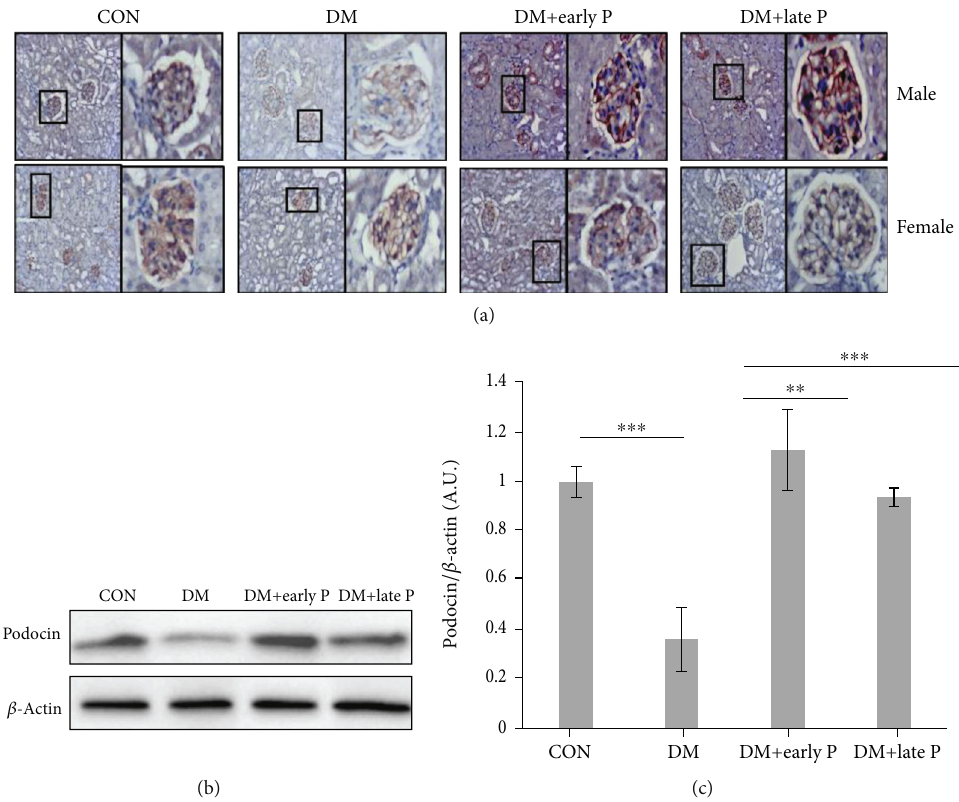
Figure 6: Immunohistochemical analysis of podocin expression in mouse renal tissues. (a) Immunohistochemical (IHC) analysis of podocin expression in mouse kidney sections. Podocin staining was lower in DM as compared to control (CON) mice, while both early and late paricalcitol treatments restored podocin levels. Magni fi cation, × 20. (b) Representative western blots of podocin and β -actin proteins extracted from mouse renal tissues. (c) Quanti fi cation of total western blots. Renal podocin levels were signi fi cantly lower in DM ( n = 14 ) as compared to control mice ( n = 11 ) ( ∗∗∗ p < 0 : 001 ). A signi fi cant increase in podocin levels was observed in paricalcitol-treated (DM +early P ( n = 10 ), DM+late P ð n = 9 Þ treatments) as compared to DM mice ( ∗∗ p < 0 : 01 , ∗∗∗ p < 0 : 001 , respectively). Error bars correspond to